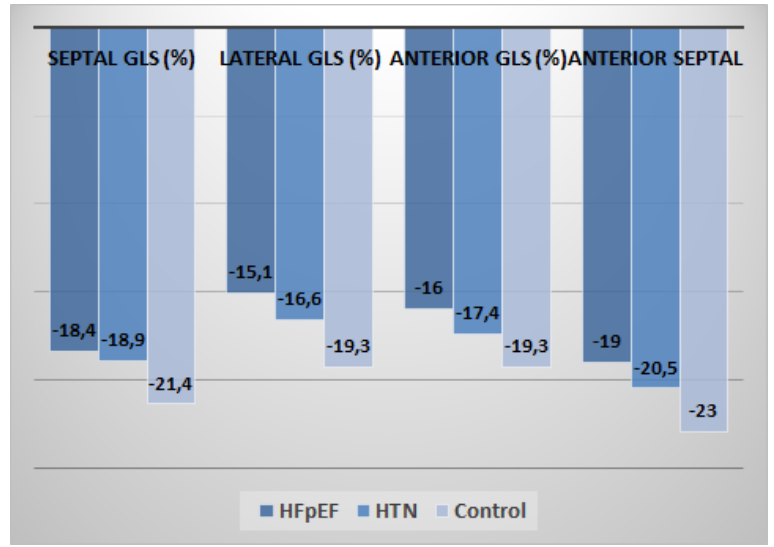
Figure 5. Distribution of mean regional longitudinal strain values at mid-level between the three groups ( n = 148).